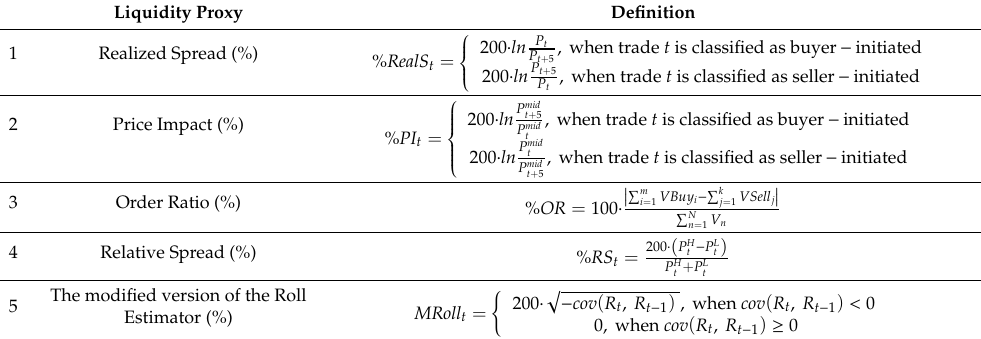
Table 1. Definitions of liquidity estimates derived from high-frequency